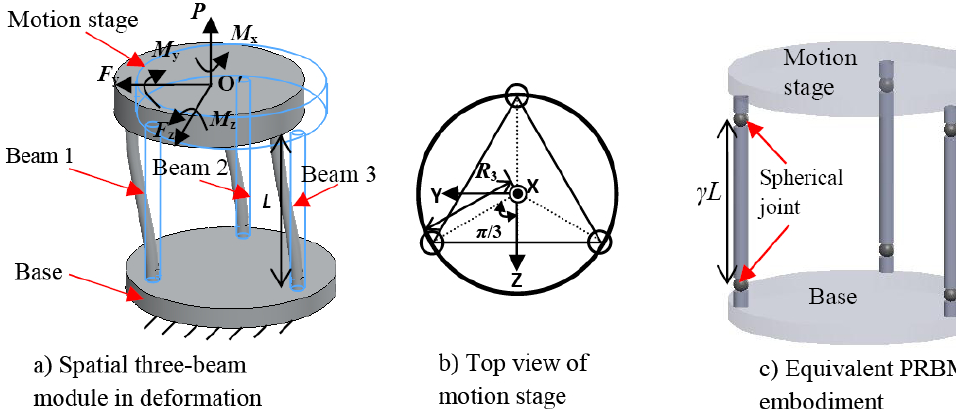
Figure 4. Spatial three-beam module and the corresponding PRBM.